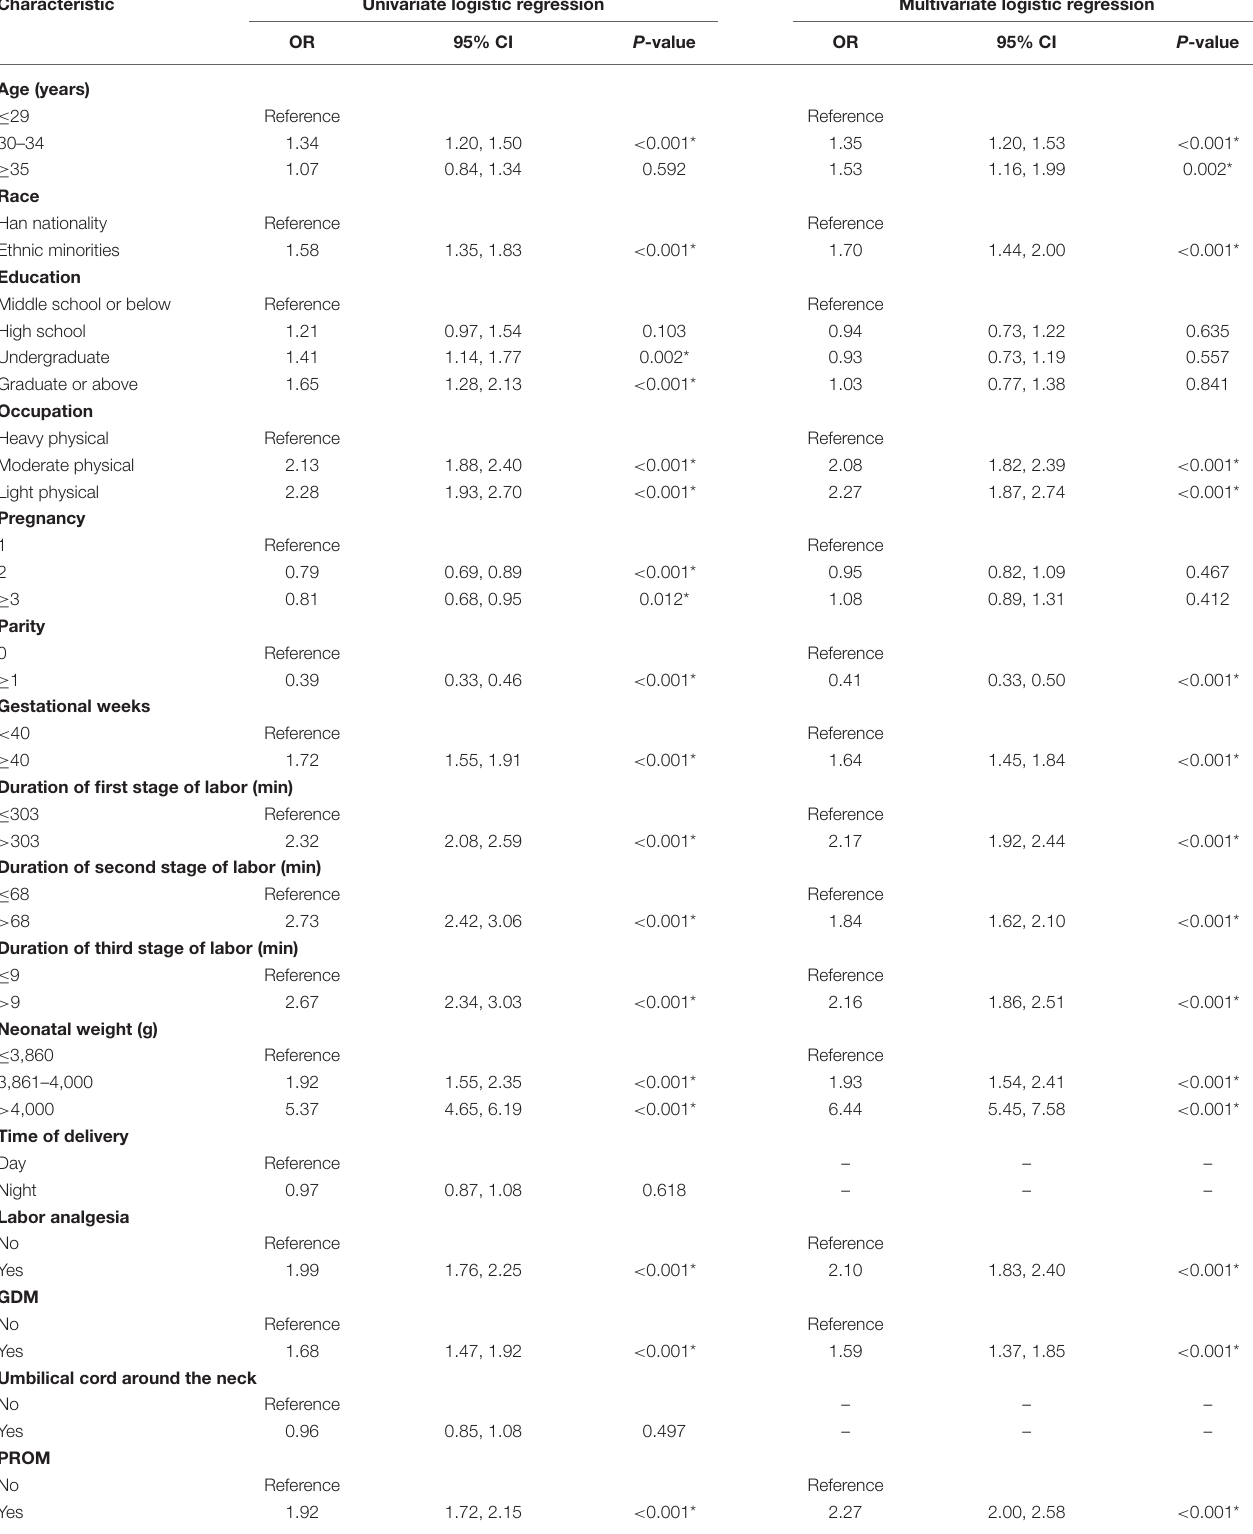
TABLE 2 | Univariate and multivariate logistic regression analyses of postpartum hemorrhage. Characteristic Univariate logistic